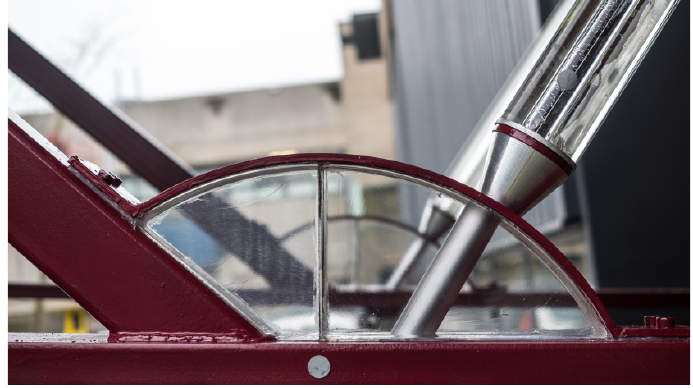
Fig. 19 Photo of node.